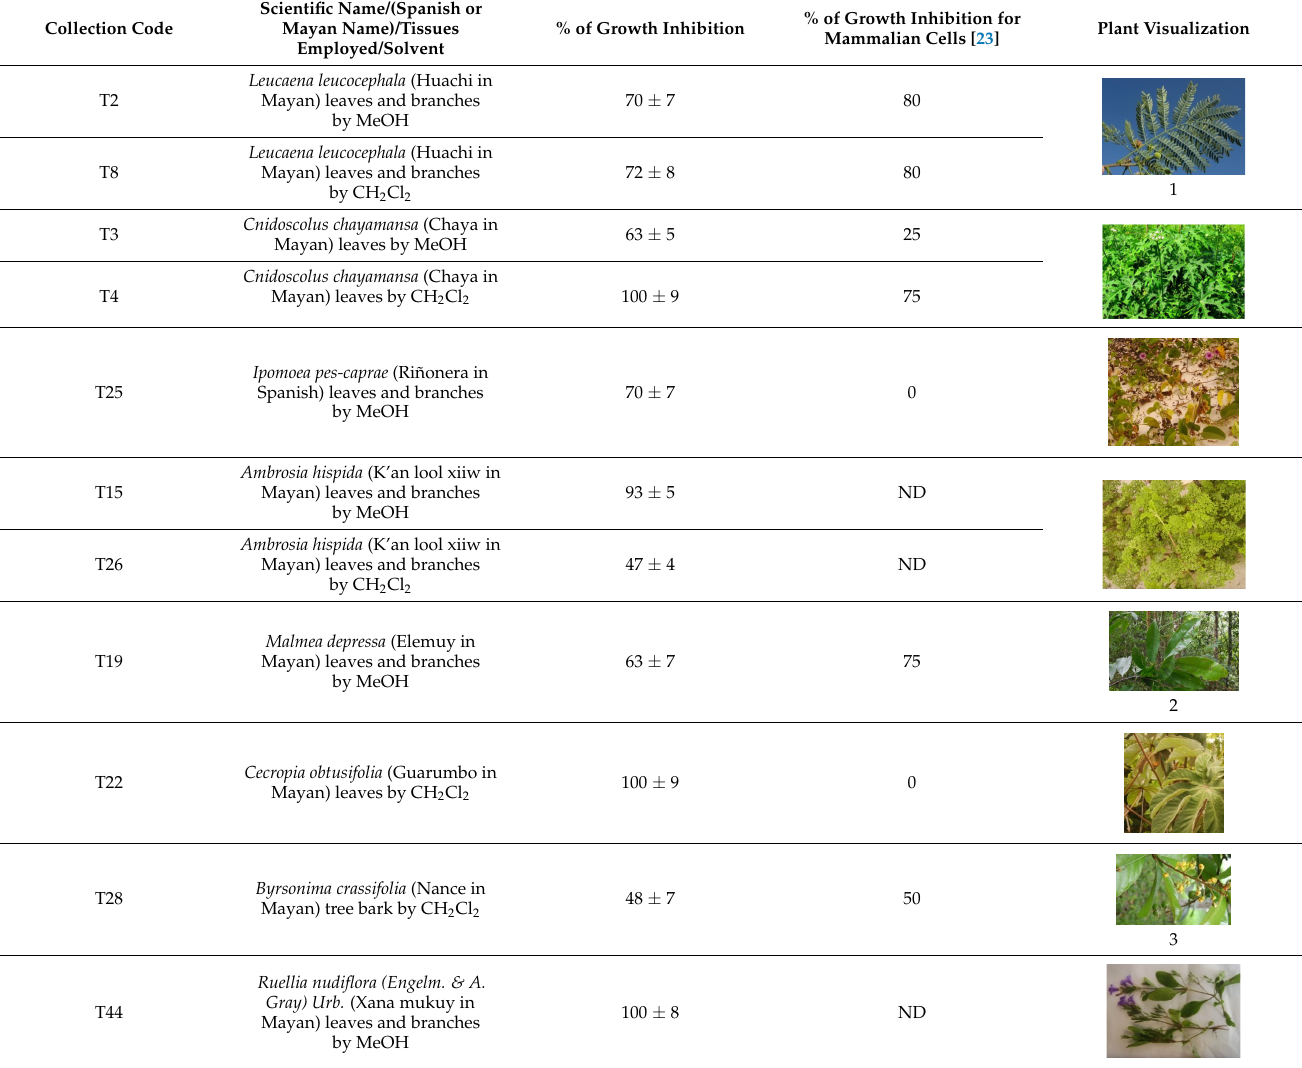
Picture from: 1-Comisión Nacional para el Conocimiento y Uso de la Biodiversidad (CONABIO) 2-IREKANI, Instituto de Biología—UNAM 3-Flora de la Península de Yucatán Herbario CICY, Unidad de Recursos Naturales. ND: not determined.